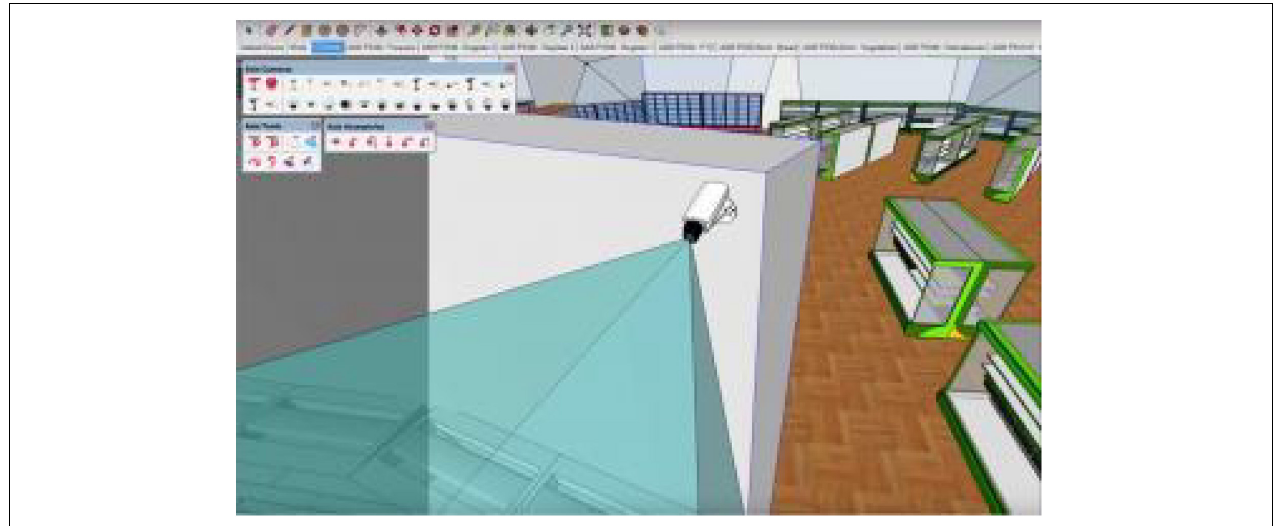
FIGURE 4 | Example of camera coverage in indoor buildings (AXIS Coverage Shape